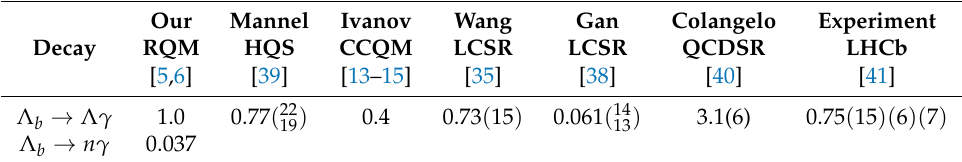
Table 7. Comparison of theoretical predictions for the rare radiative decay branching fraction ( with available experimental data.